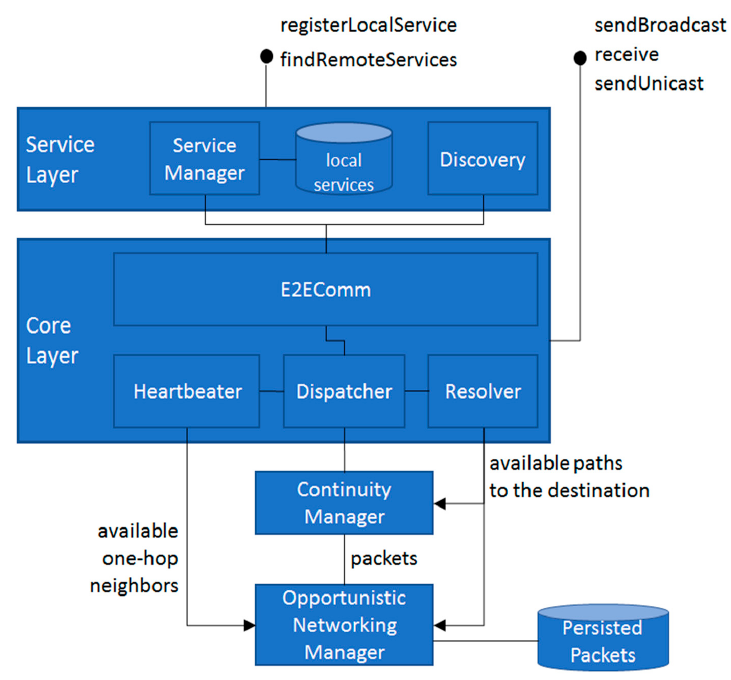
Figure 3. Real Ad-hoc Multi-hop Peer-to peer (RAMP) Opportunistic Networking (RON) architecture.